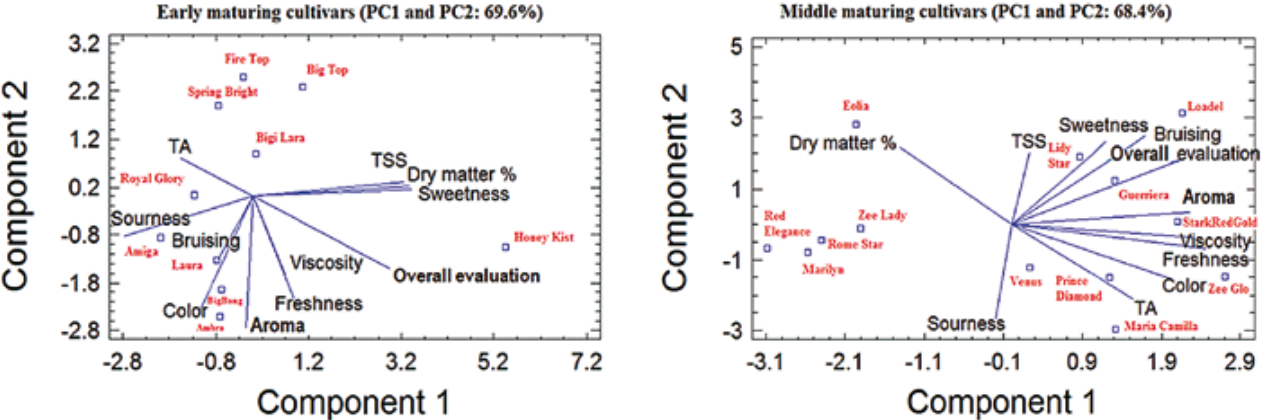
Fig. 1 - Biplot graphs for Group A (early maturing) and Group B (middle maturing) varieties. Grouping of peaches, nectarines and clingstone peaches according to their physical, chemical and sensorial attributes determined